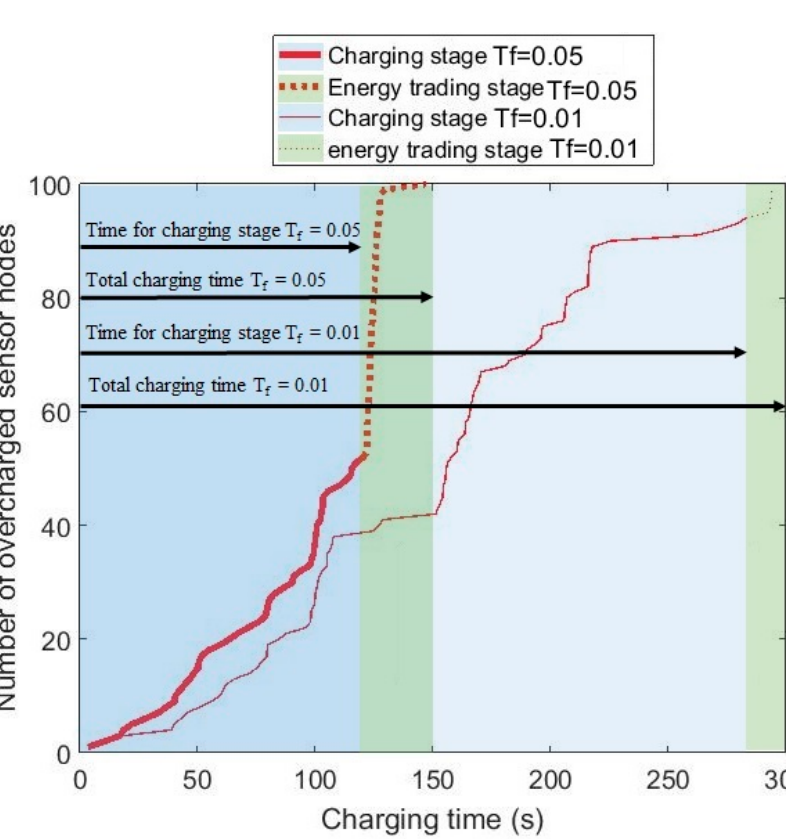
Figure 13. Number of overcharged sensor nodes as a function of time with 12 dB antenna gain for T f = 0.01 and T f = 0.05.